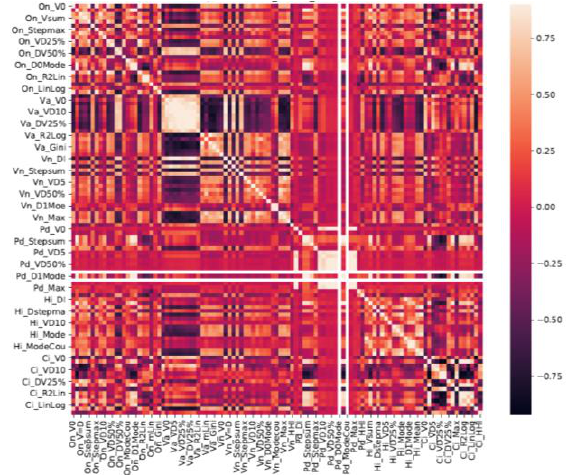
Figure 8 . Correlation heatmap for Milan